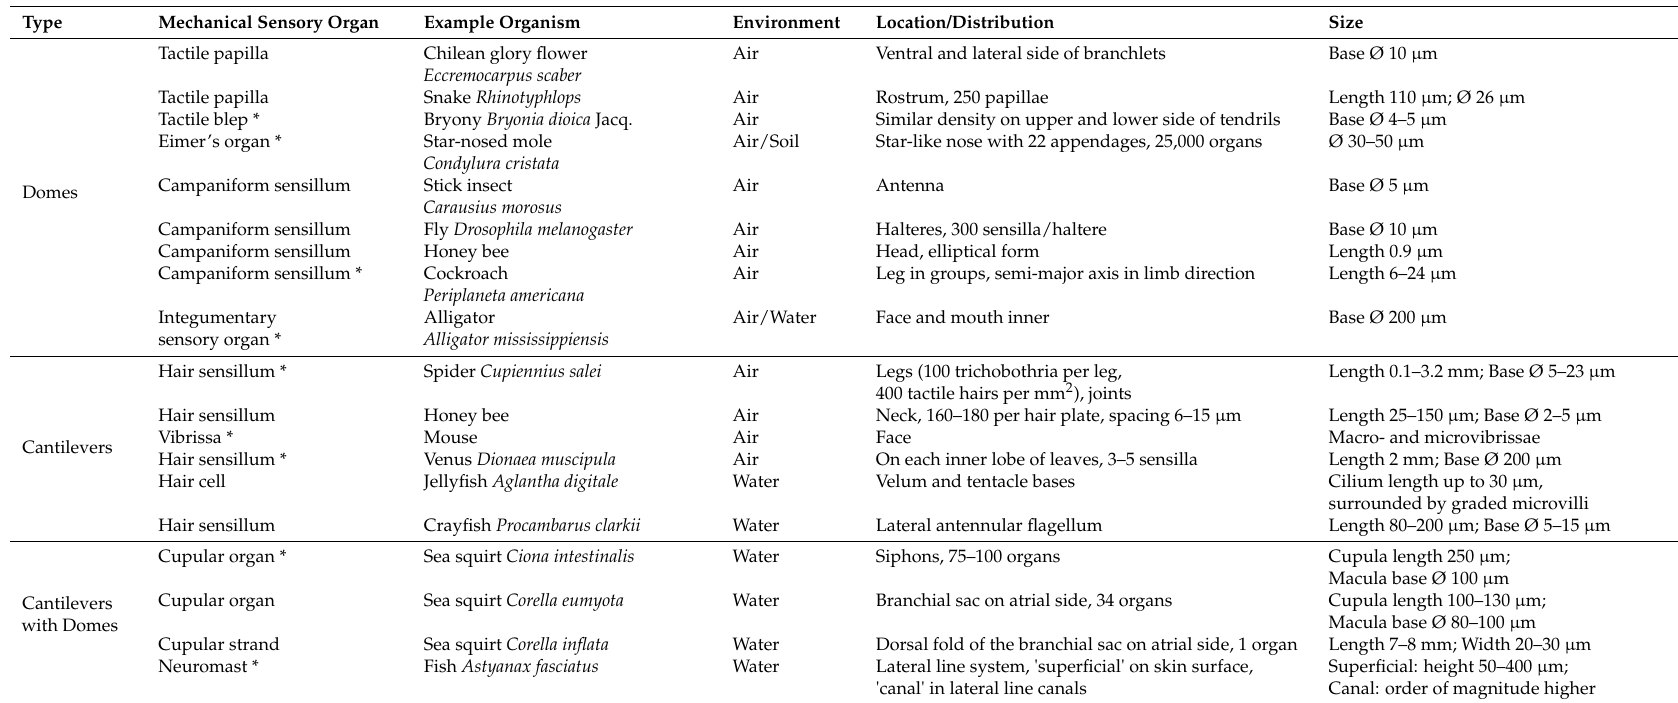
Table 1. Selection of specialized mechanical sensory organs with significant biomechanical